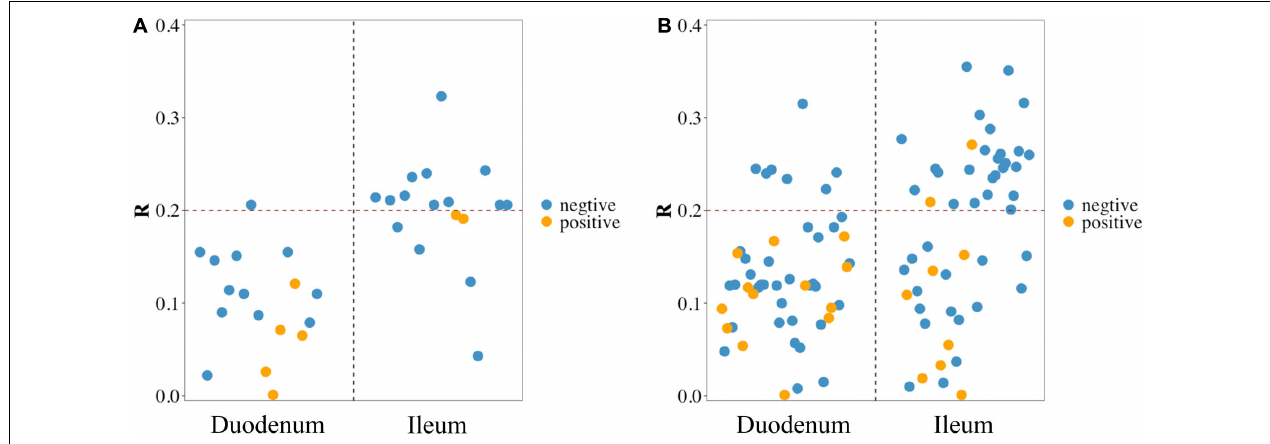
FIGURE 3 | Pearson correlation between feed conversion ratio (FCR) and microbes in the duodenum and ileum at phylum level (A) and genus level (B) . Blue/yellow dot in scatter diagram: microbes in the corresponding intestinal segment negative/positive correlated with FCR.